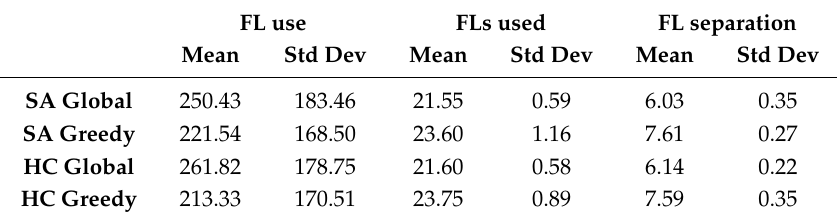
Table 4. Analysis of the FLs used for the different algorithms and δ =